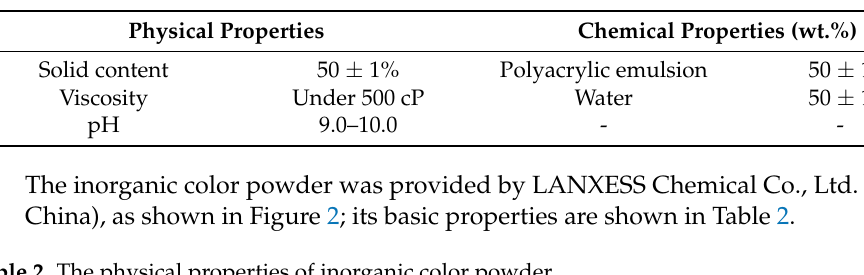
Table 2. The physical properties of inorganic color powder. Color